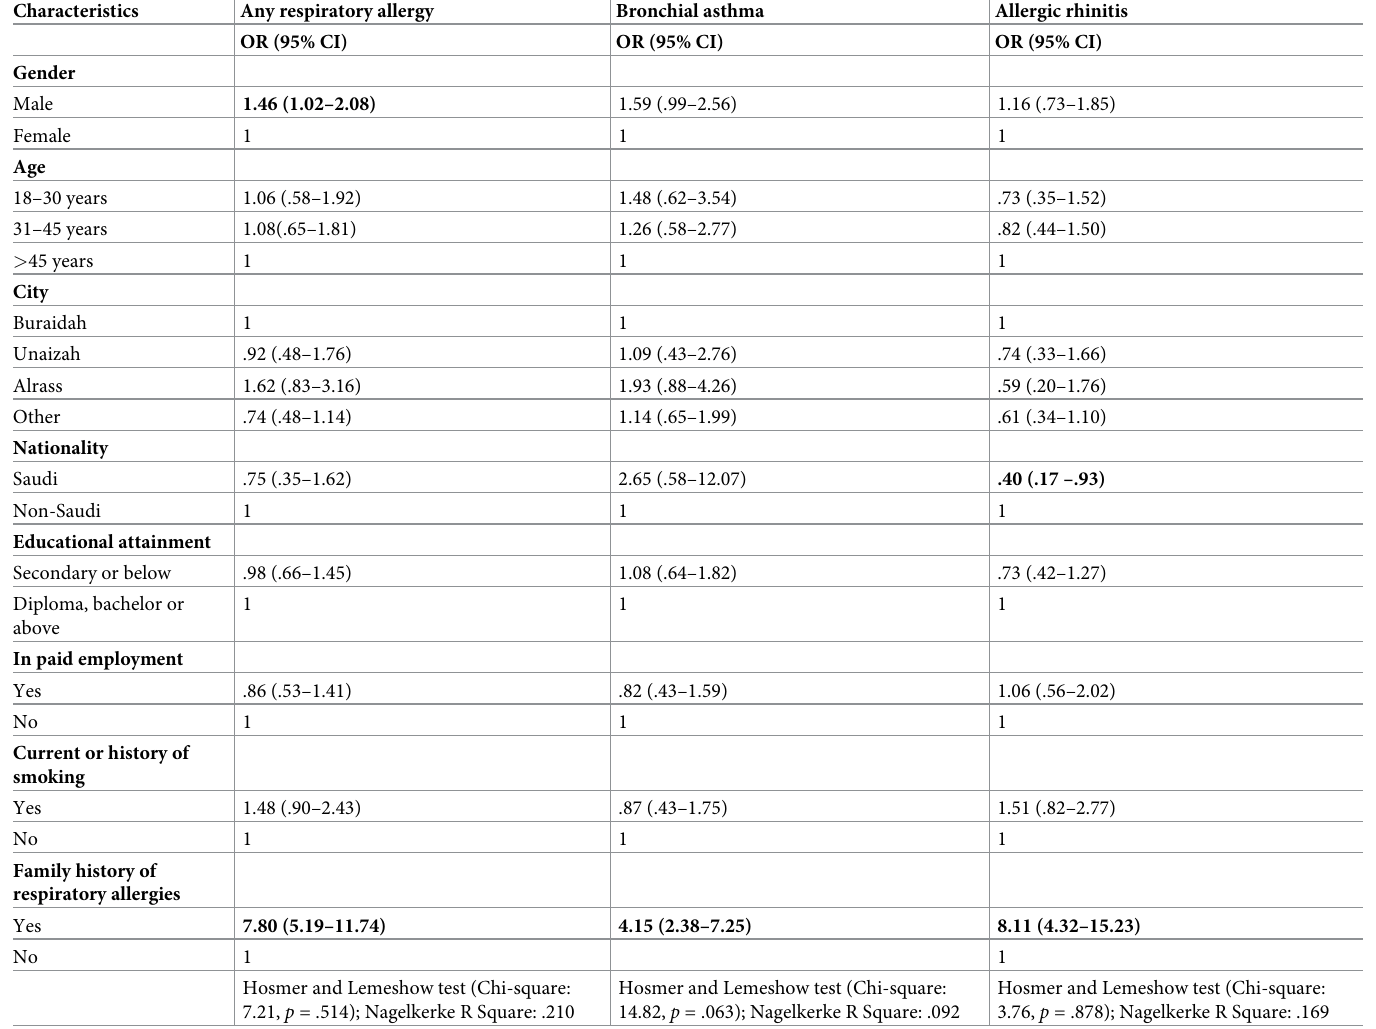
Table 4. Predictors of respiratory allergies in Qassim, KSA, September–December 2020.